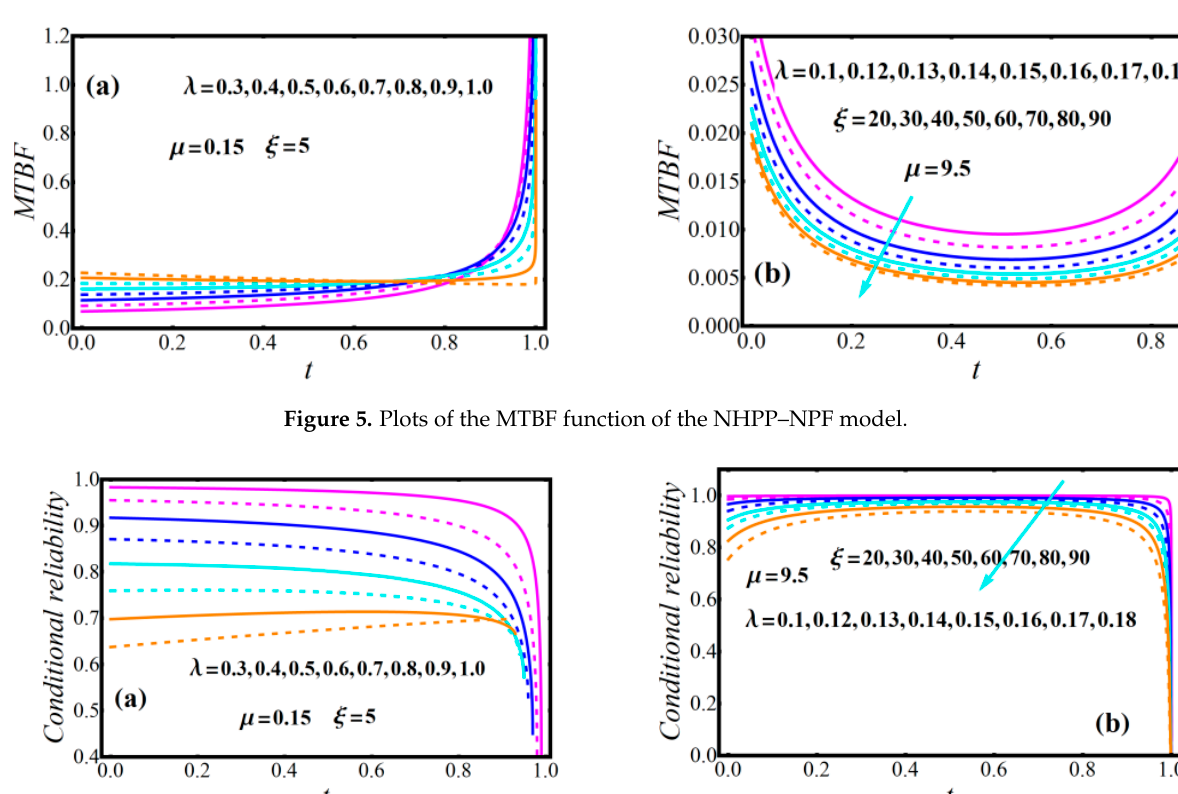
Figure 4. Plots of the error detection rate function of the NHPP–NPF model.